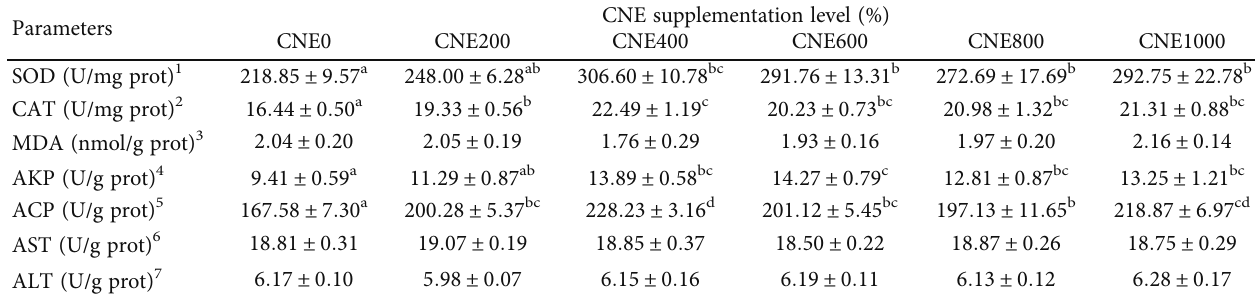
Table 7: Liver biochemical biochemistry of juvenile H . otakii fed the experimental diets for 8 weeks. CNE supplementation level (%) Parameters